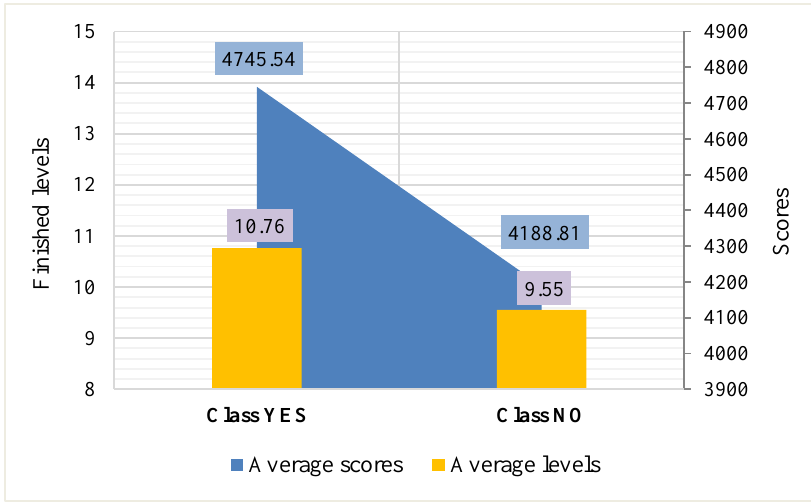
Fig. 4. Average scores and finished levels in the game “Zagonetke mudrog lisca” differentiated by whether students take additional classes in